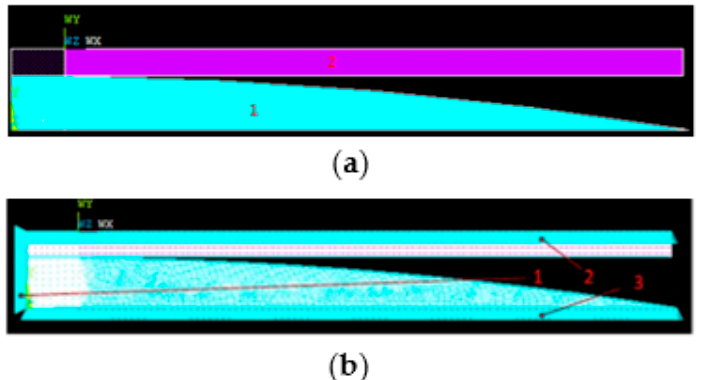
Figure 13. ( a ) Model composed of polyoxymethylene spherical cap 1 mated with moving rigid cylinder 2; ( b ) Mesh of finite elements and boundary conditions.